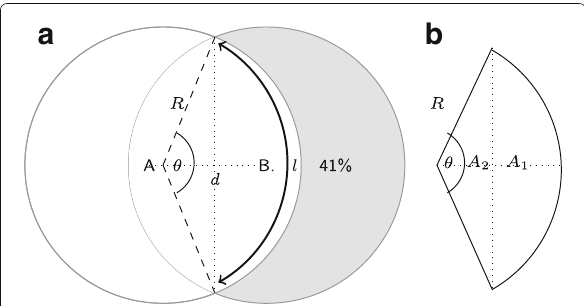
Fig. 9 Estimating average distance d av between source and a neighbor. a Intersection between transmission ranges. b Calculating area of wedge